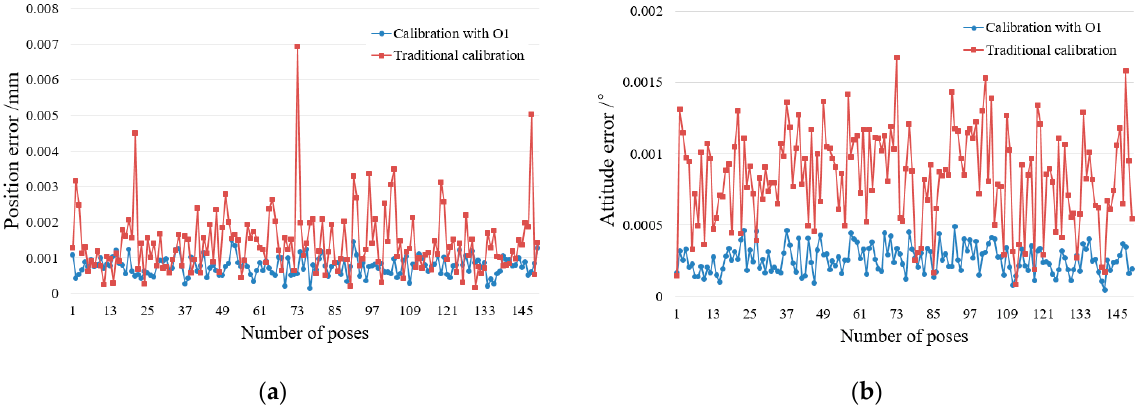
Figure 9. Position and a tt itude errors of 150 primary mirror poses. ( a ) Position errors; ( b ) A tt itude errors.